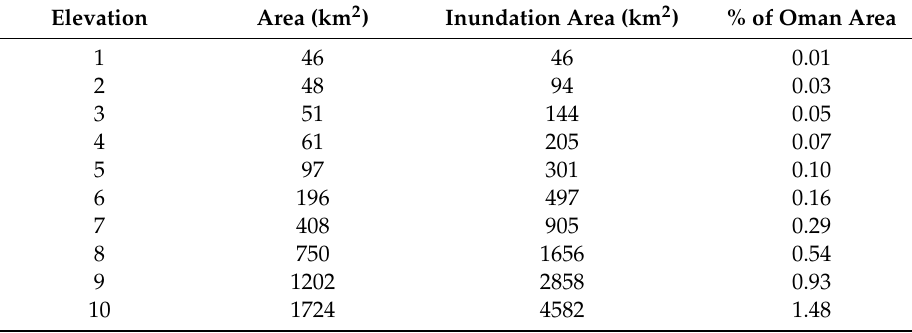
Figure 3. Areas of the elevation levels (1–10 m) and the population of coastal governorates in 2017. Table 2. The coastal elevations and inundation areas between 1 and 10 m along Oman